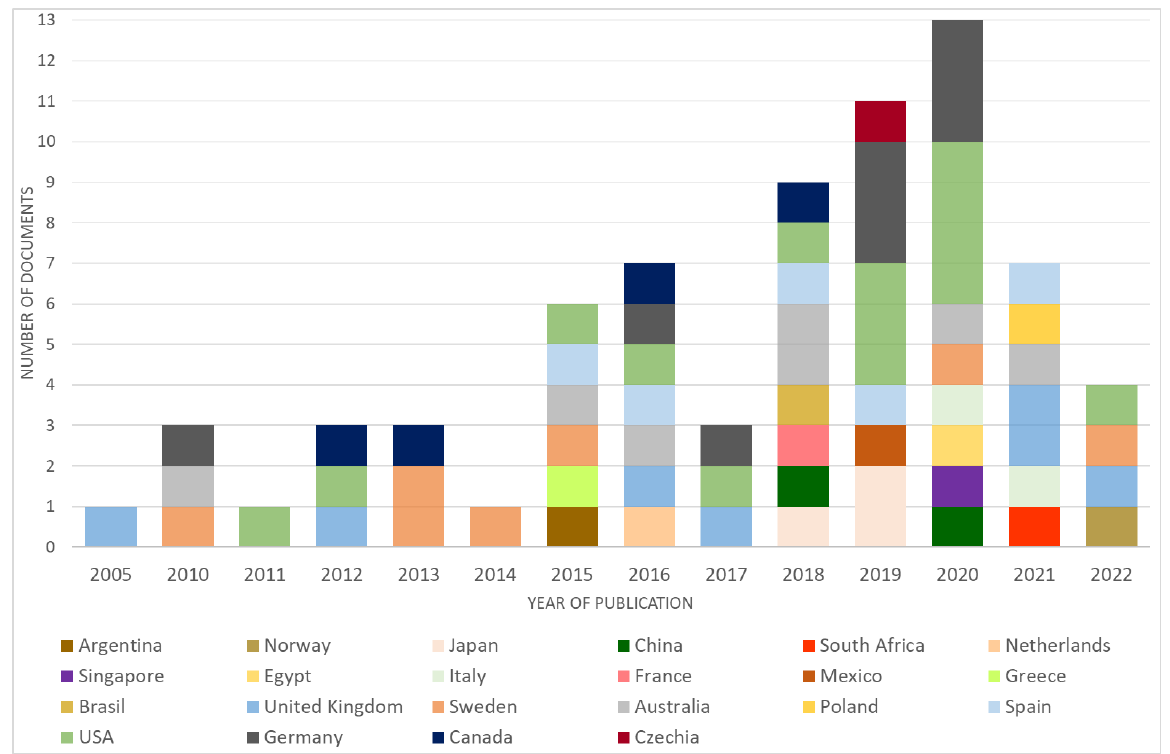
Figure 2. Years of publication and countries of the corresponding author ’ s home University of included literature.